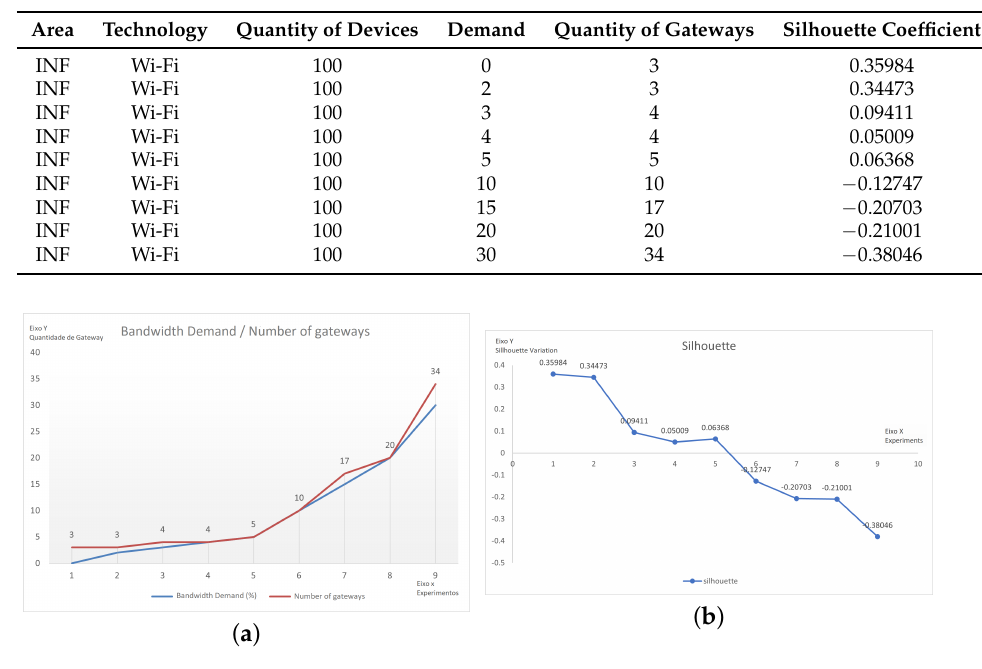
Figure 9. Graphs showing the results of the experiments with variations in the demand for data link consumption: ( a ) the data link consumption × quantity of gateways; ( b ) the silhouette